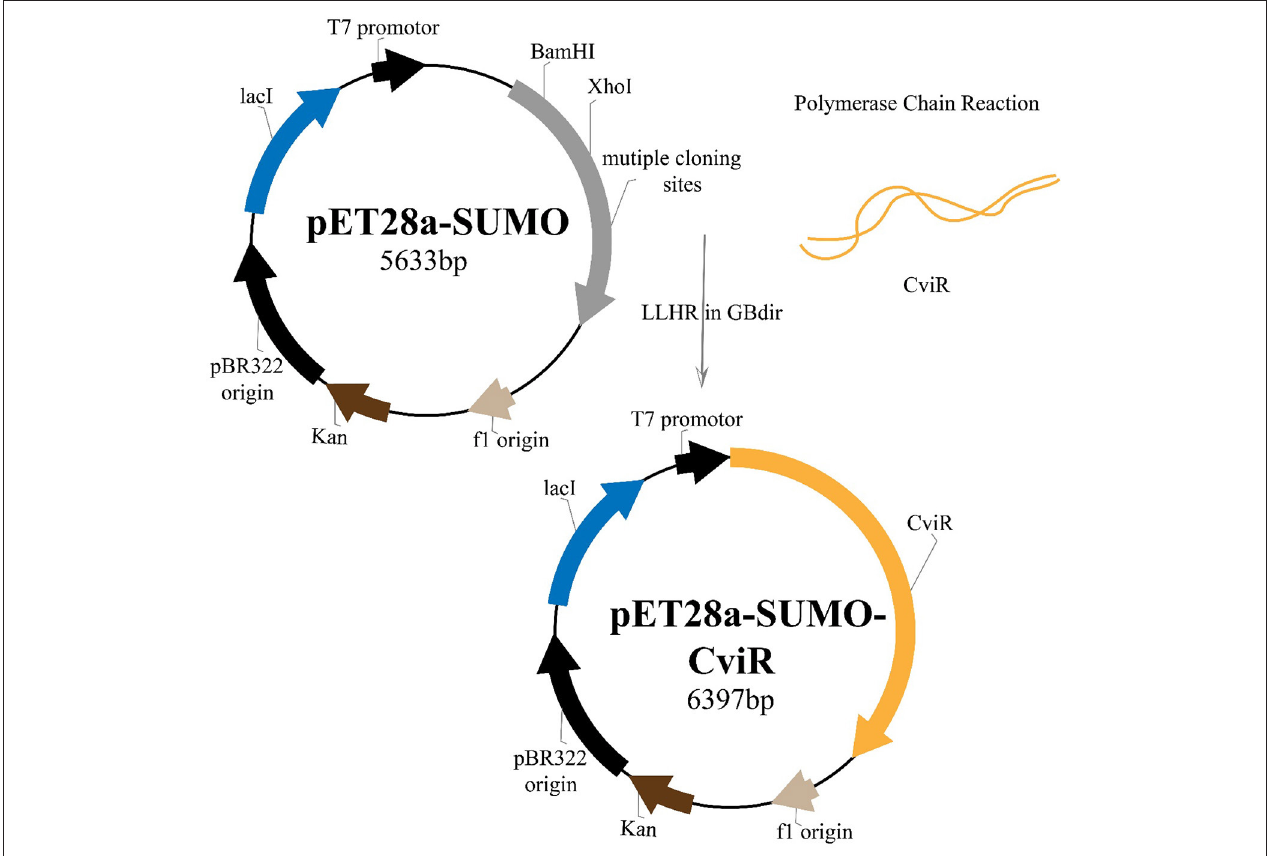
FIGURE 7 | Plasmid construction and the recombineering strategy followed for the heterologous expression of CviR